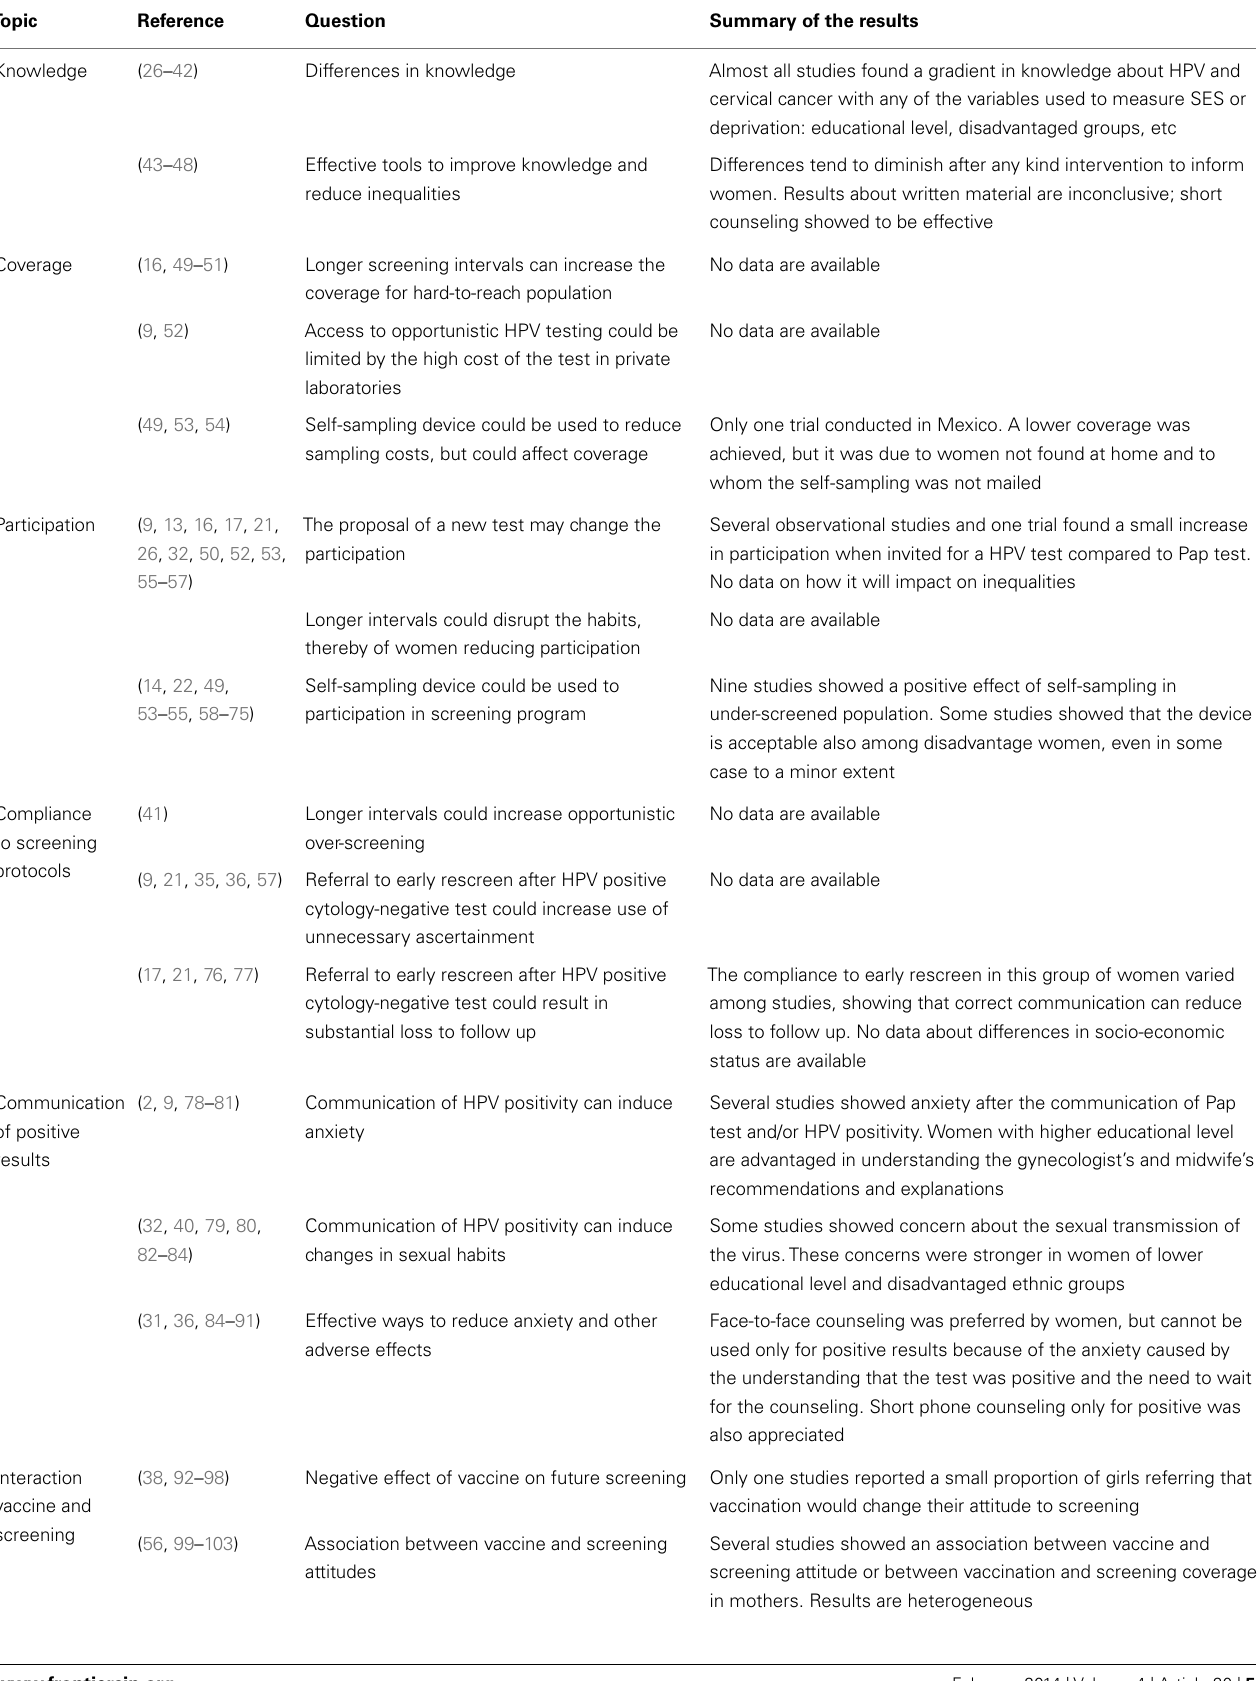
Table 1 | Summary of the questions and results emerged from the systematic